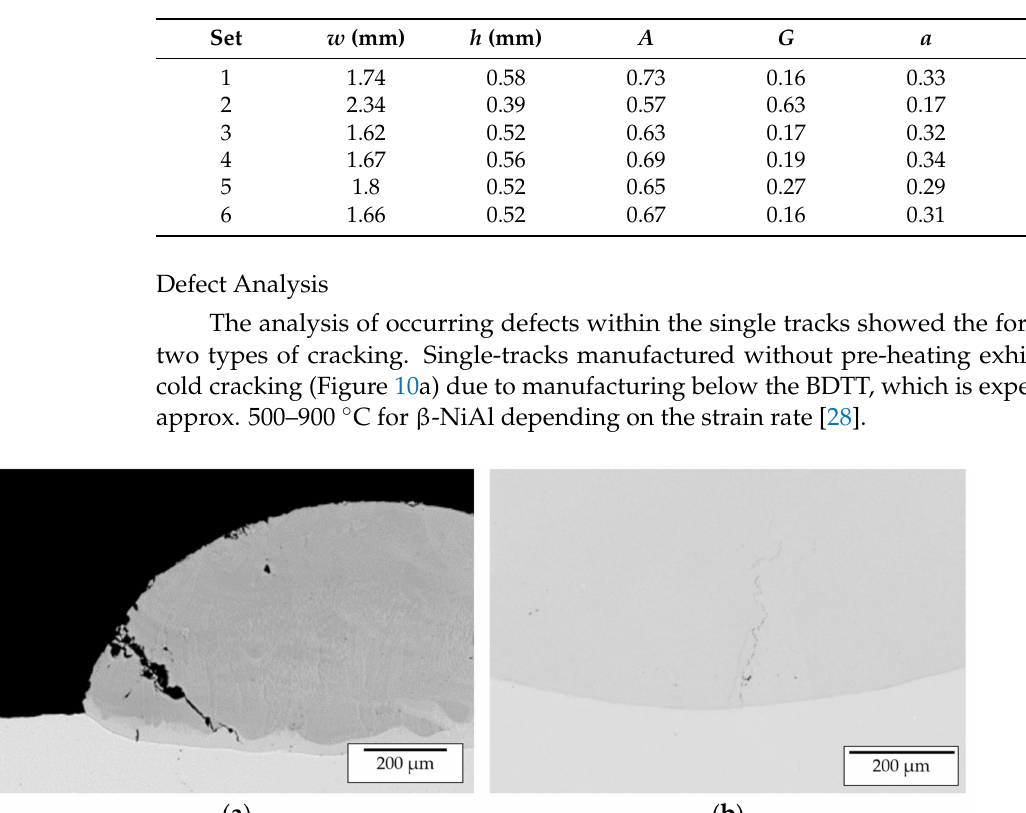
Table 6. Geometrical features of the deposited tracks for the selected sets of parameters.